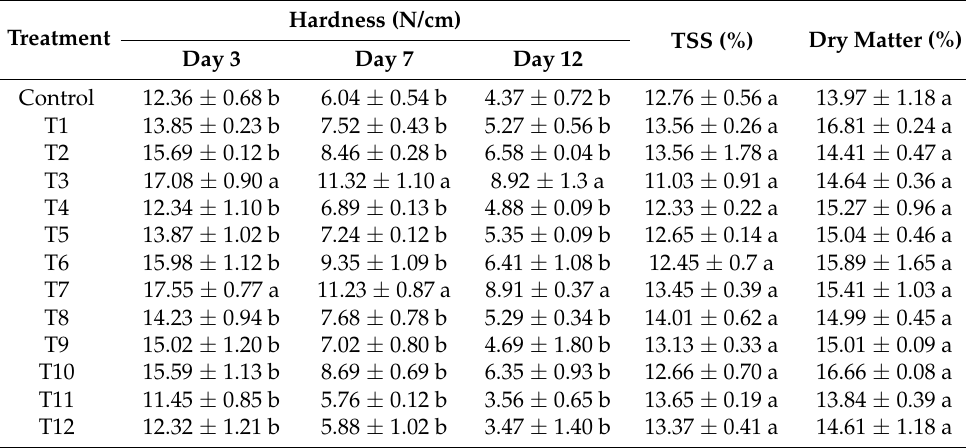
Table 3. Effect of different treatments on the kiwifruit ( Actinidia chinensis ) ‘Donghong’ postharvest quality under cold